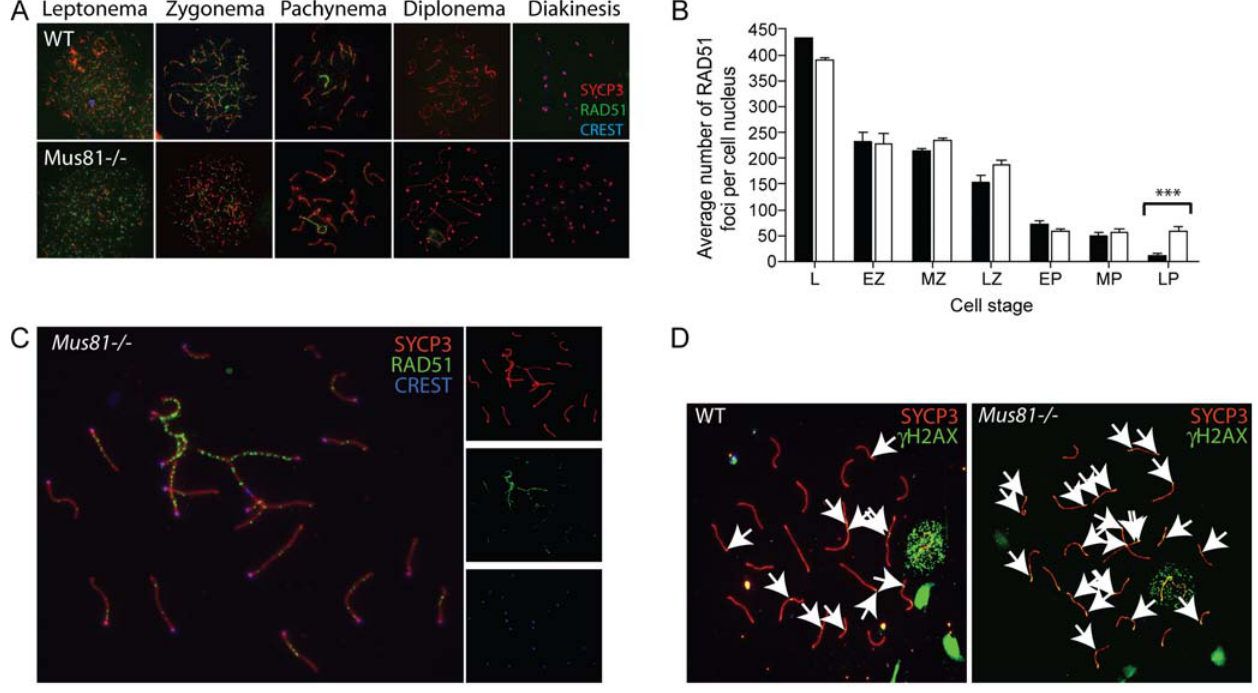
Figure 2. Meiotic recombination analysis in WT and Mus81 2 / 2 spermatocytes by immunofluorescent staining and diakinesis spreads. A, B) RAD51 staining persists in late pachynema. A) WT (top panel) and Mus81 2 / 2 (bottom panel) spermatocytes stained with antibodies against SYCP3 (red), RAD51 (green) and CREST autoimmune serum (blue) in the five substages of Prophase I; Leptonema, Zygonema, Pachynema, Diplonema and Diakinesis. B) RAD51 focus numbers are not statistically different in Mus81 2 / 2 spermatocytes (shown as white bars) compared to WT (black) except in late pachynema, where they persist in Mus81 2 / 2 (significant difference shown by the asterisk). C) Mus81 2 / 2 spermatocytes stained with antibodies against SYCP3 (red), RAD51 (green) and CREST autoimmune serum (blue) during late pachynema. D) WT (left panel) and ( Mus81 2 / 2 ) spermatocytes were stained with antibodies to SYCP3 (red) and phosphorylated c H2AX (green). c H2AX foci are highlighted by the arrows. doi:10.1371/journal.pgen.1000186.g002 PLoS Genetics |